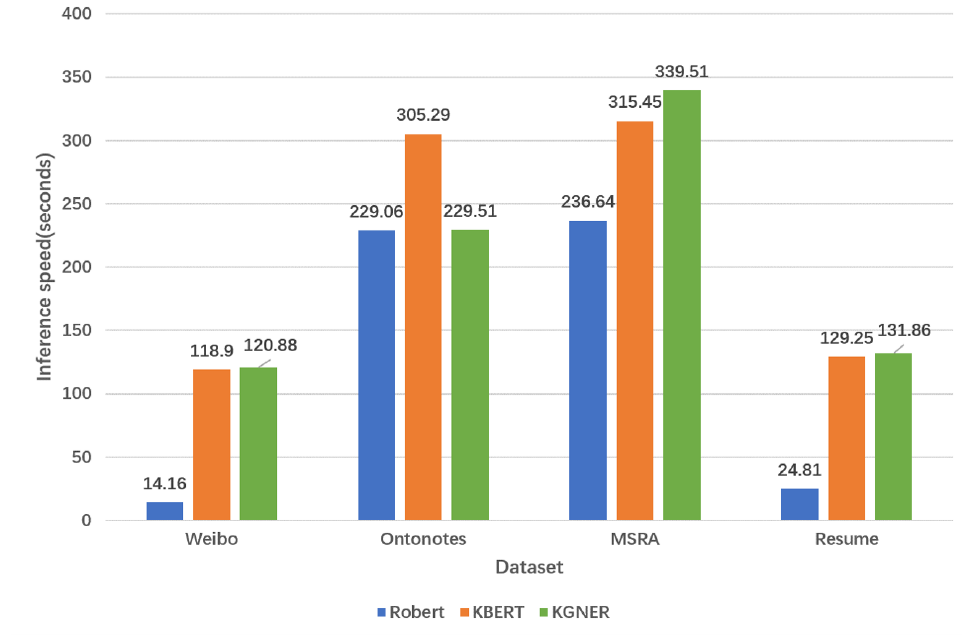
Figure 6. Inference speed on the four datasets.